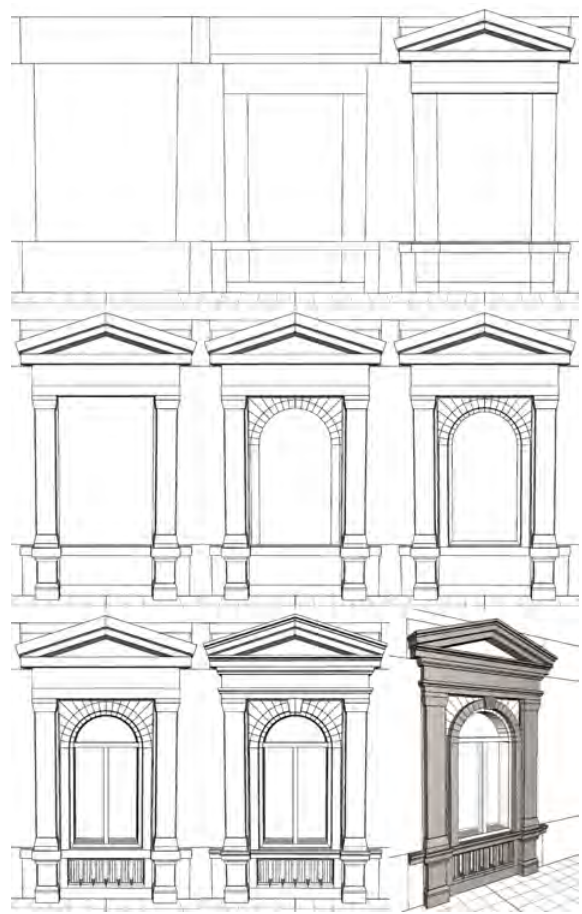
Figure 7: Interactive window modeling using procedural